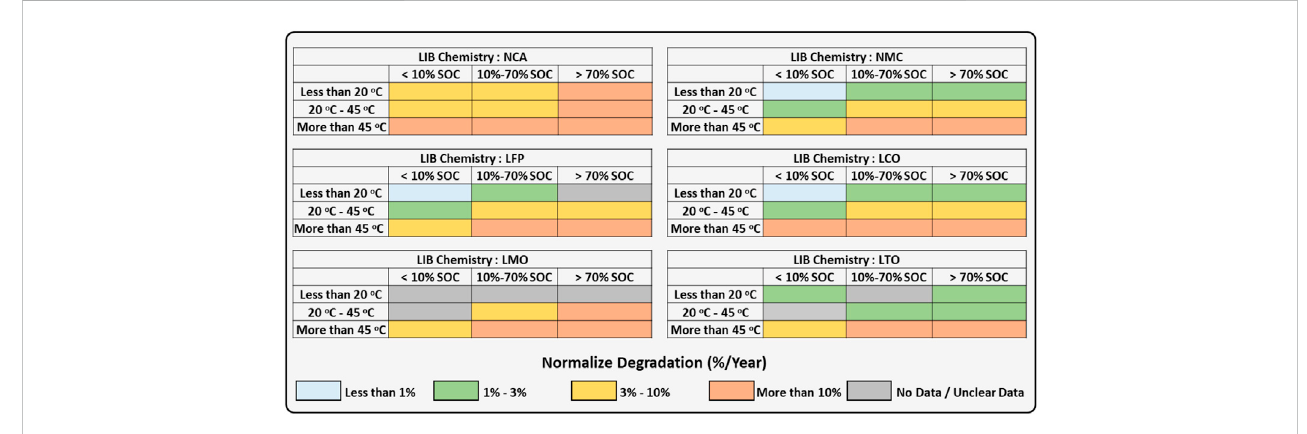
FIGURE 4 Summary of calendar aging for all LIB chemistry.